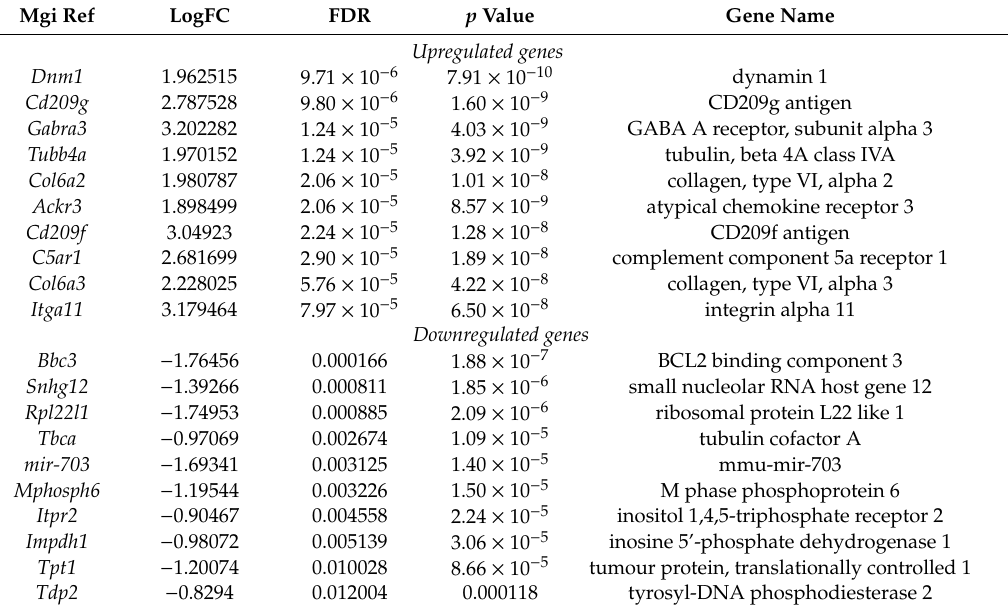
Table 2. Top 10 genes upregulated ( + logFC) or downregulated ( − logFC) by HFA